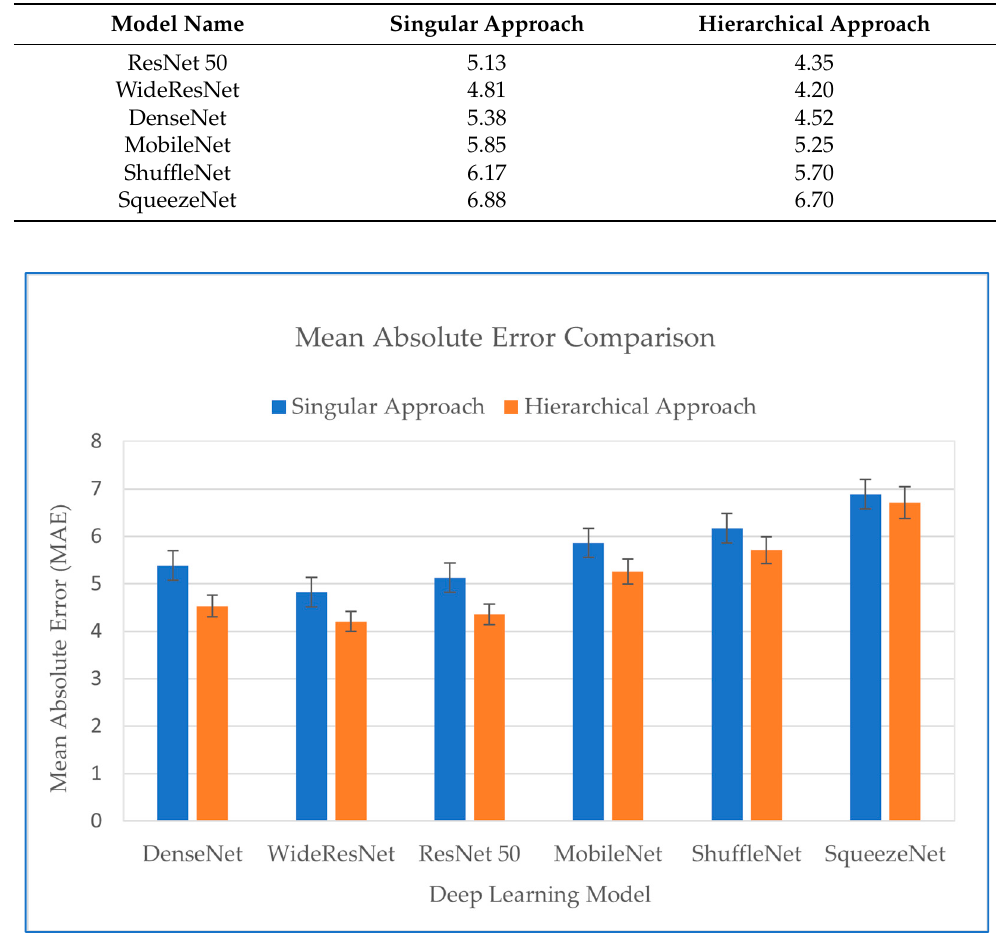
Figure 7. The performance comparison of different CNN models in real age estimation.